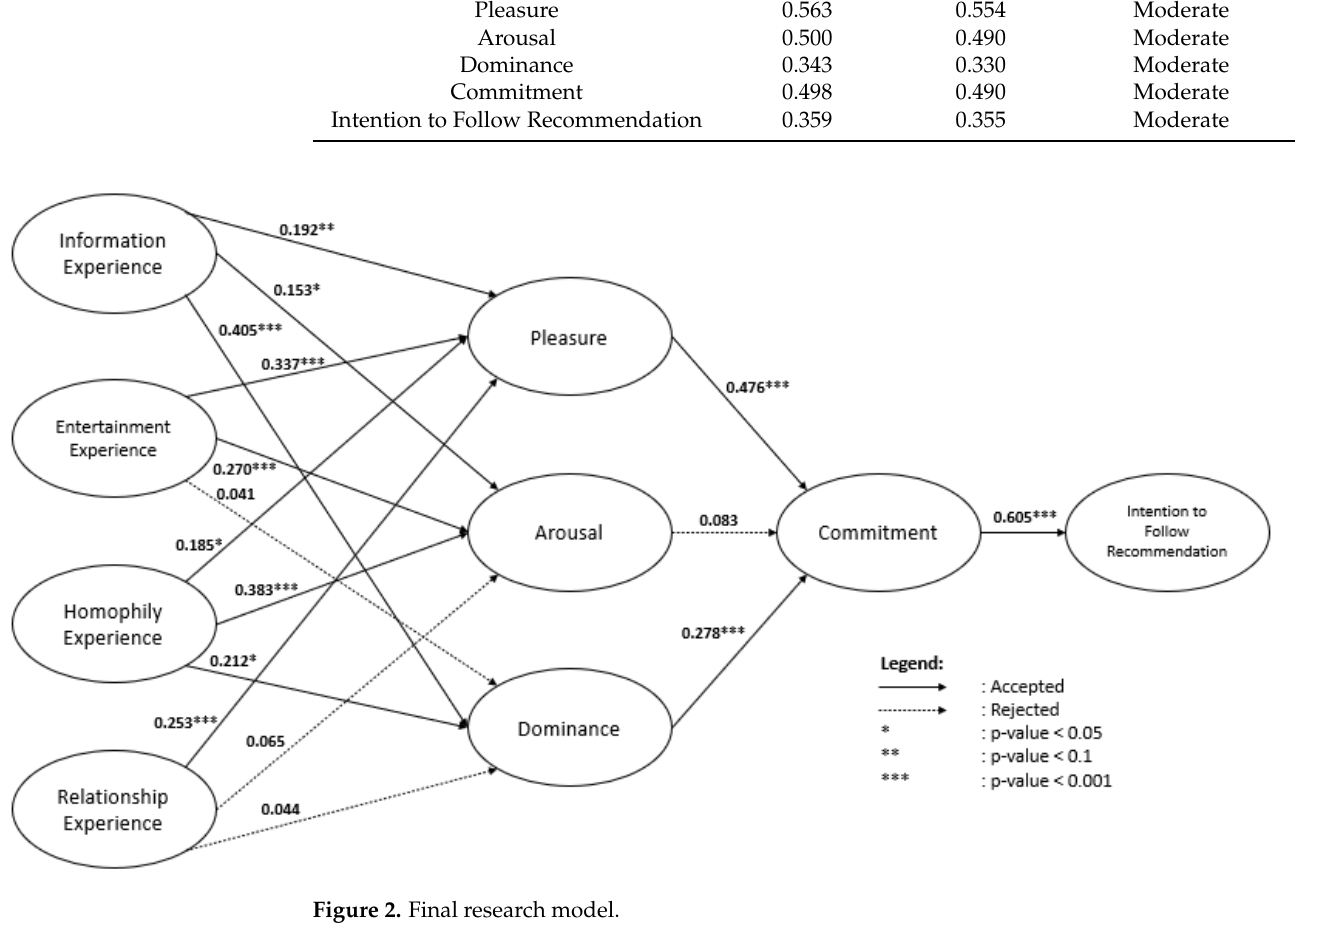
Figure 2. Final research